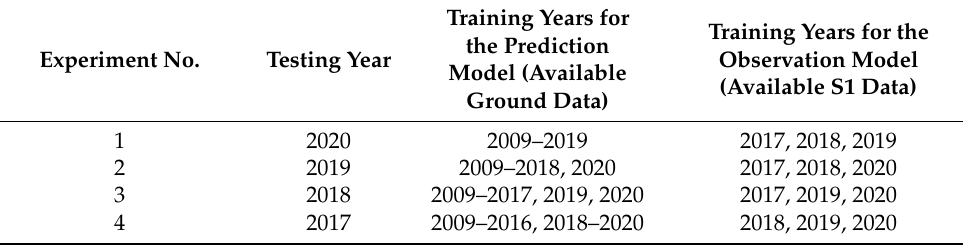
Table 4. List of testing and training years for each experiment undertaken. Experiment No. Testing Year